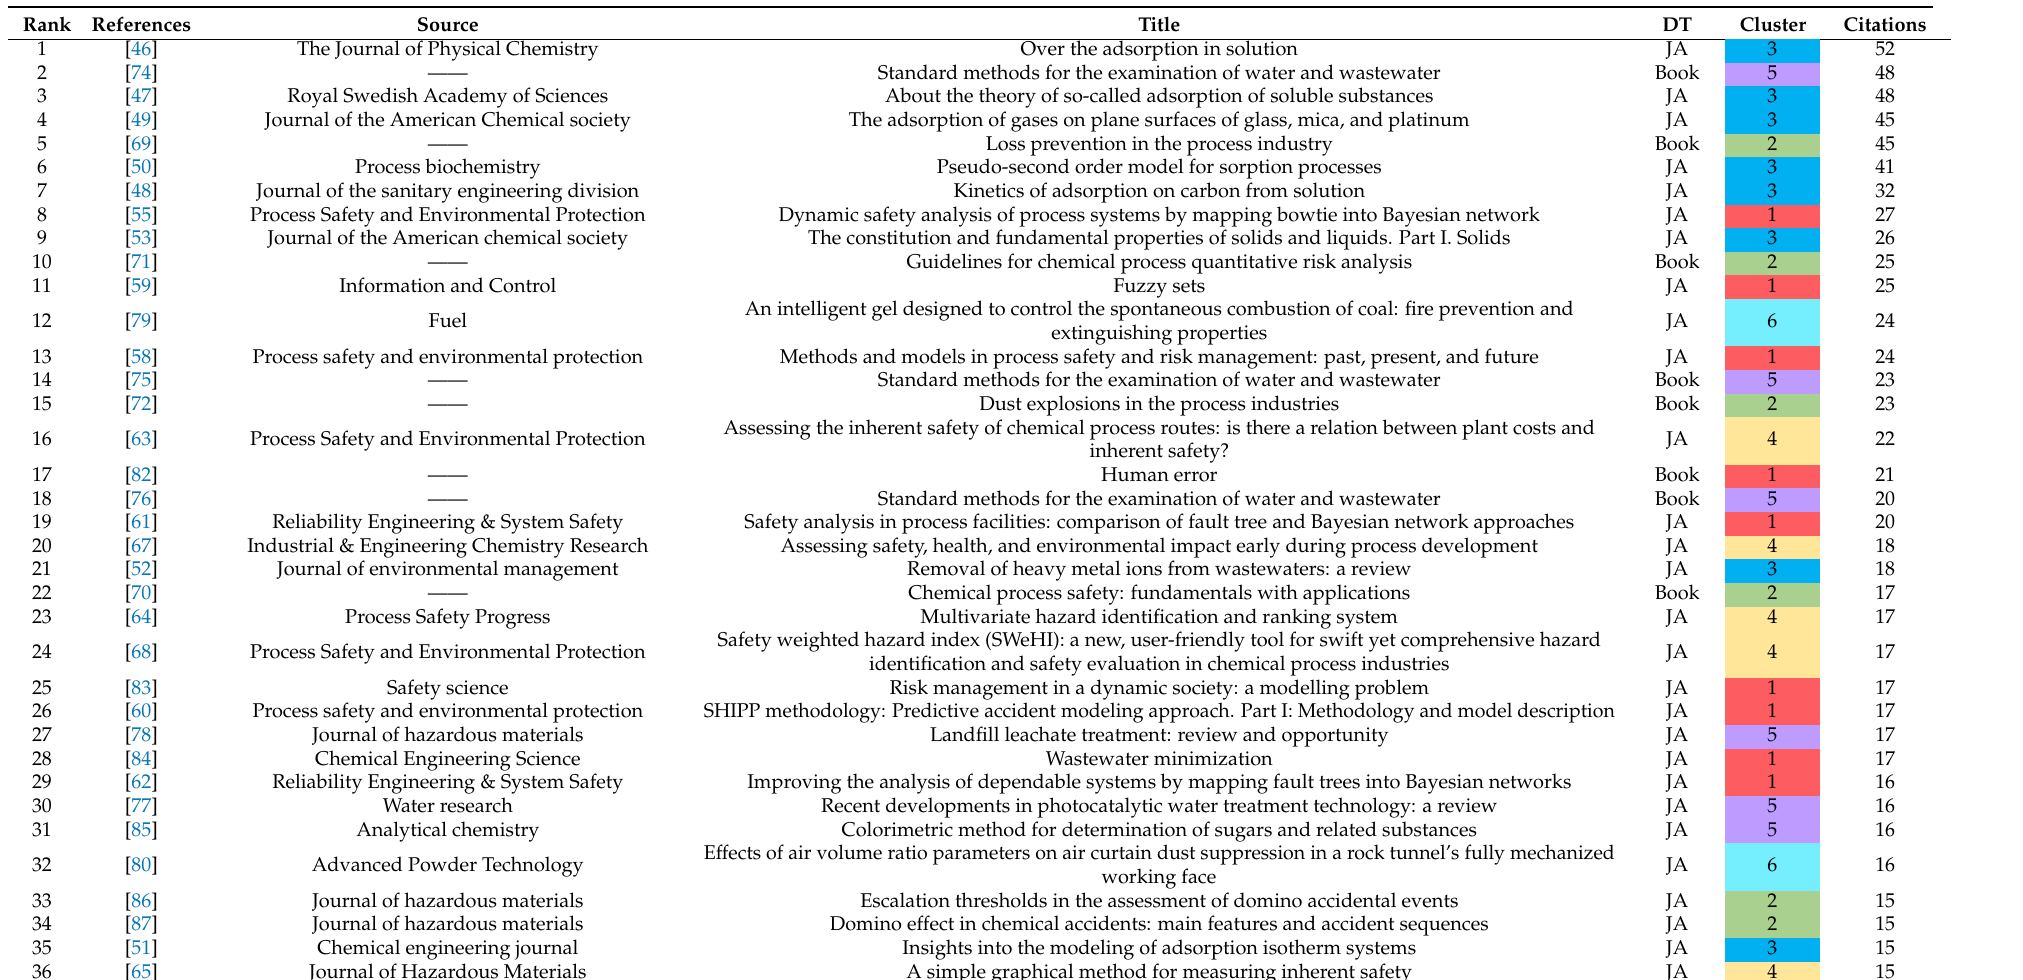
Table 6. Highly cited references of PSEP publications ranked by the number of